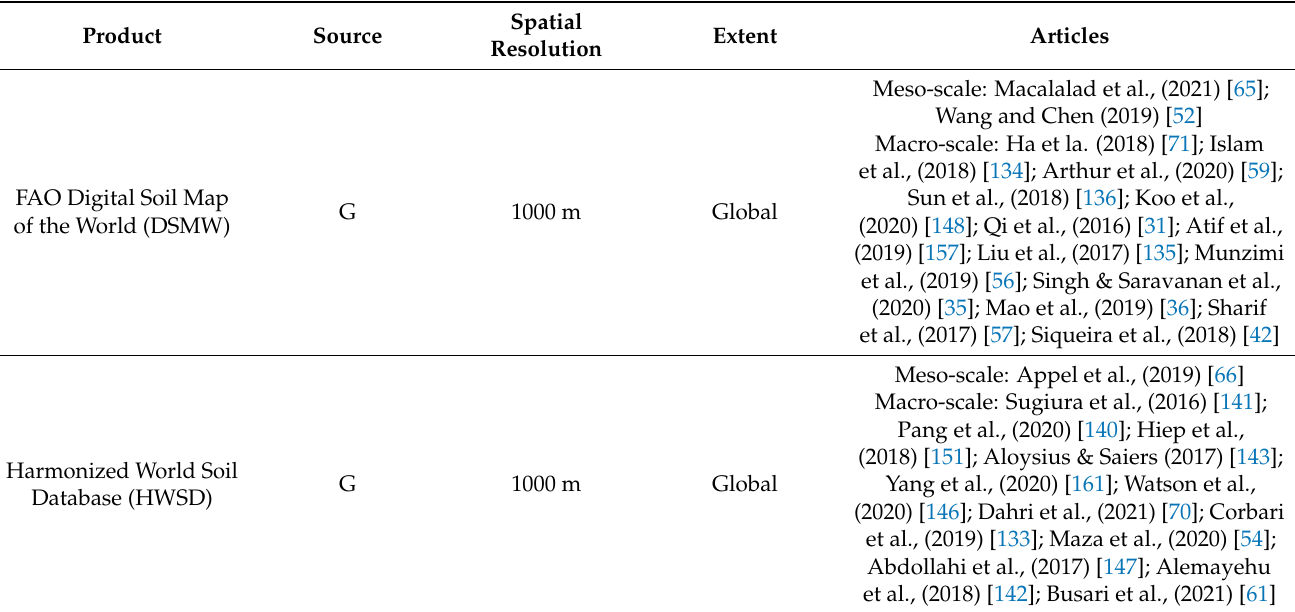
Table A4. Soil distribution and properties datasets used in reviewed